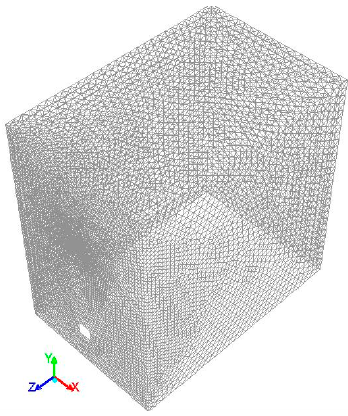
Figure 5. The mesh structure.